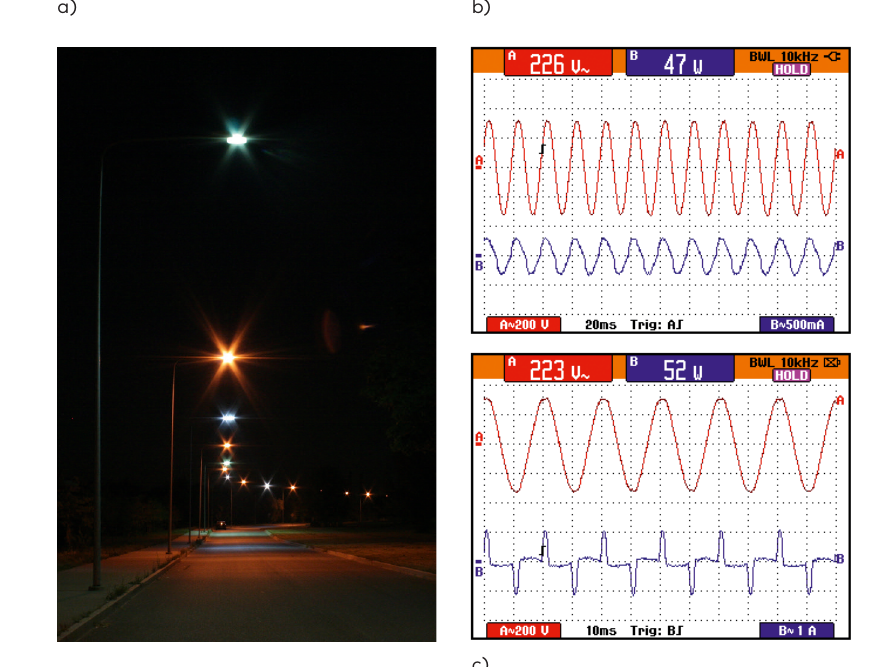
Figure 10. Results of measurements performed in 2009: a – picture of dry road PilotSite in Riga; b – AC voltage and current waveform for Cobrahead 48.7W luminary; c – AC voltage and current waveform for Diodella 52W